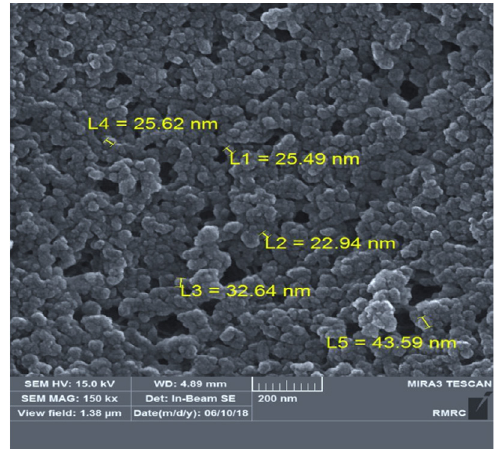
Fig. 4. FE-SEM imaging on the surface of the particles for 0.1mg /mL concentrtion of the